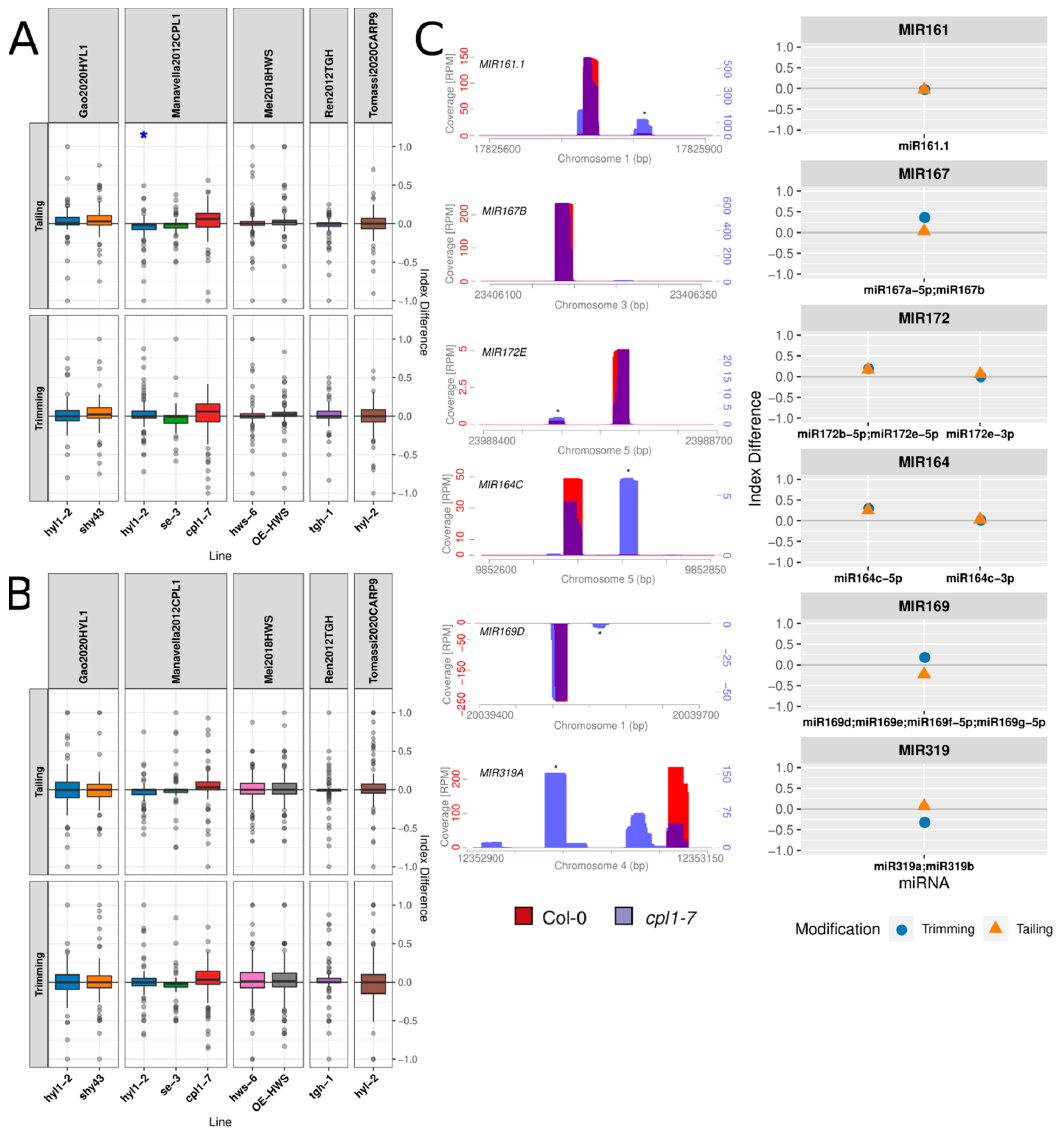
Figure 2. Trimming and tailing index differences of miRNAs in mutants of genes related to miRNA biogenesis: ( A ) distribution of IDs of guide miRNAs and ( B ) distribution of IDs of miRNAs*, where asterisks over the boxplots indicate the results of paired t-test between the mean index of the line and that of the reference line, paired by miRNA, and * p - value below 0.05, ** p -value below 0.01, and *** p -value below 0.001. Tests were grouped by the modification evaluated, trimming or tailing, and p -values were FDR-corrected across all studies analyzed in this work. ( C ) Normalized coverage of small RNA reads at different MIR loci: the Y-axes are labeled on the first plot. Col-0 and cpl1-7 coverage colors are partially transparent and their overlap is purple. MiRNA* is indicated by an asterisk. On the right of each coverage plot, the corresponding ID values for the miRNA (and the miRNA* if annotated) are presented.